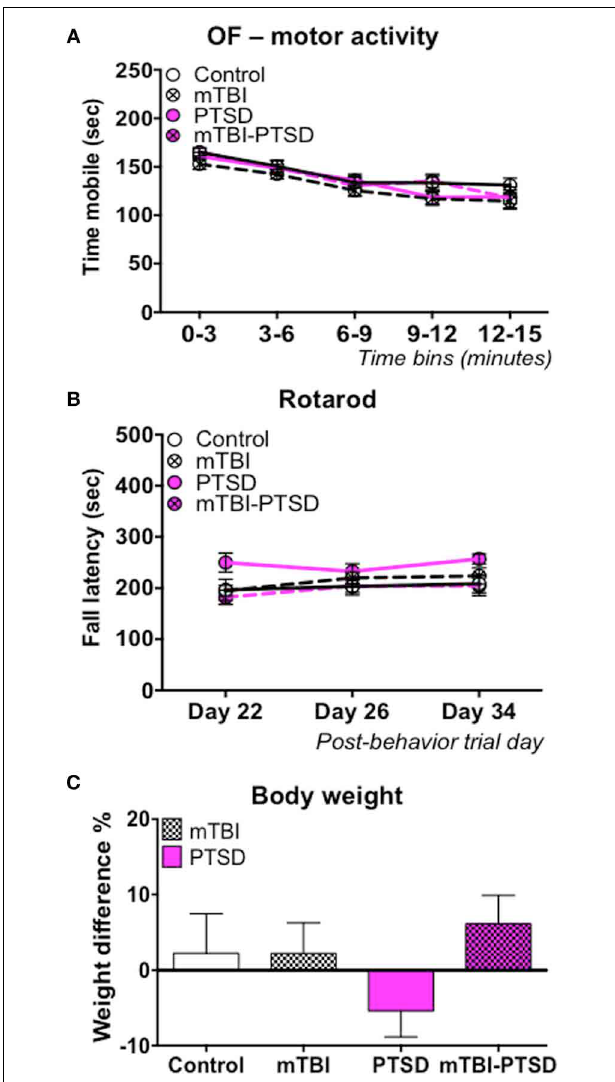
FIGURE 4 | Motor activity/coordination and growth rate. No main effect was observed in the motor activity during the open field test, and motor coordination in the rotarod test in any of the groups (A,B) . Data in (A,B) were analyzed using repeated—Two Way ANOVA followed by post-hoc Tukey’s test ( n = 11–13). Mice in the control, mTBI, and combination groups showed a 2–5% increase in body weight over the 21 day stress experimental paradigm, while PTSD only mice showed a 5% reduction in their body weight (C) . Data are presented as mean ± SEM.